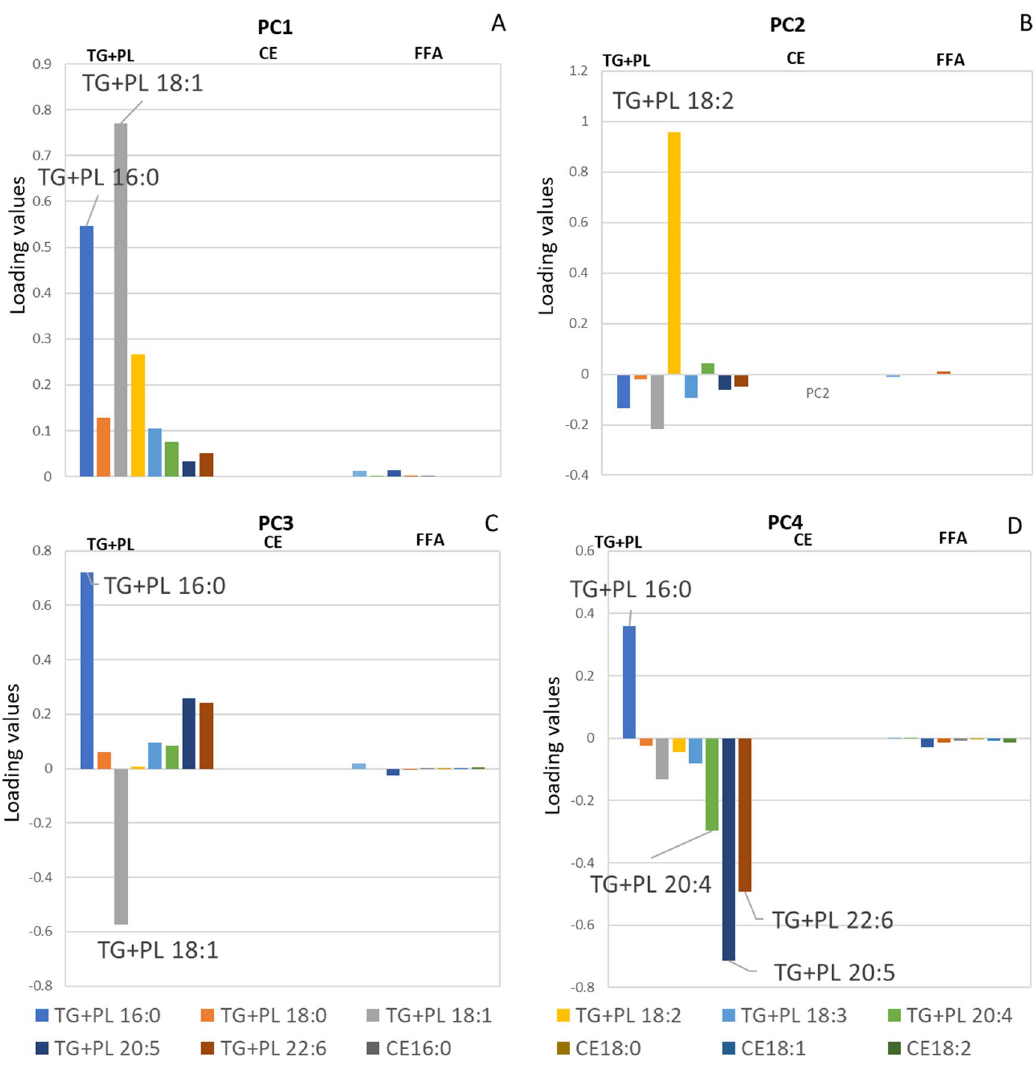
Figure 4. Histograms of PCA results, including ( A ) PC1, ( B ) PC2, ( C ) PC3, and ( D )